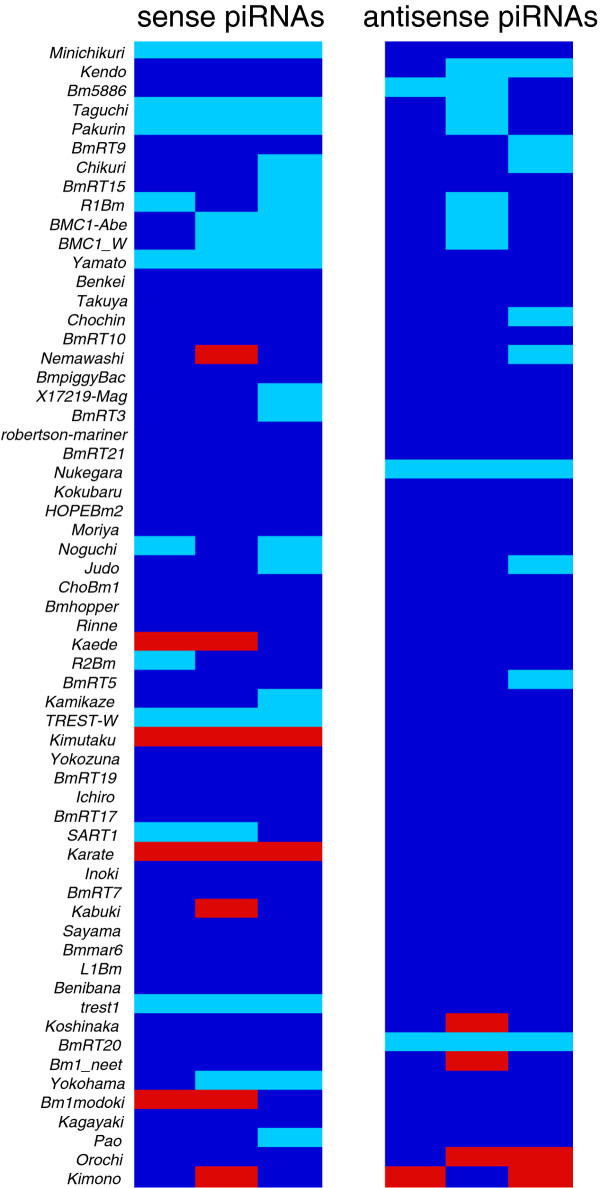
Profiling of piRNAs in the KG ovaries. Heat map showing relative abundances of sense and antisense transposon piRNAs in the KG ovaries of three individuals (WT ovarian piRNAs = 1). Blue indicates relative expression (RE) meets 0.6 ≤ RE ≤ 1.6. Light blue corresponds to RE < 0.6 and red indicates RE > 1.6.